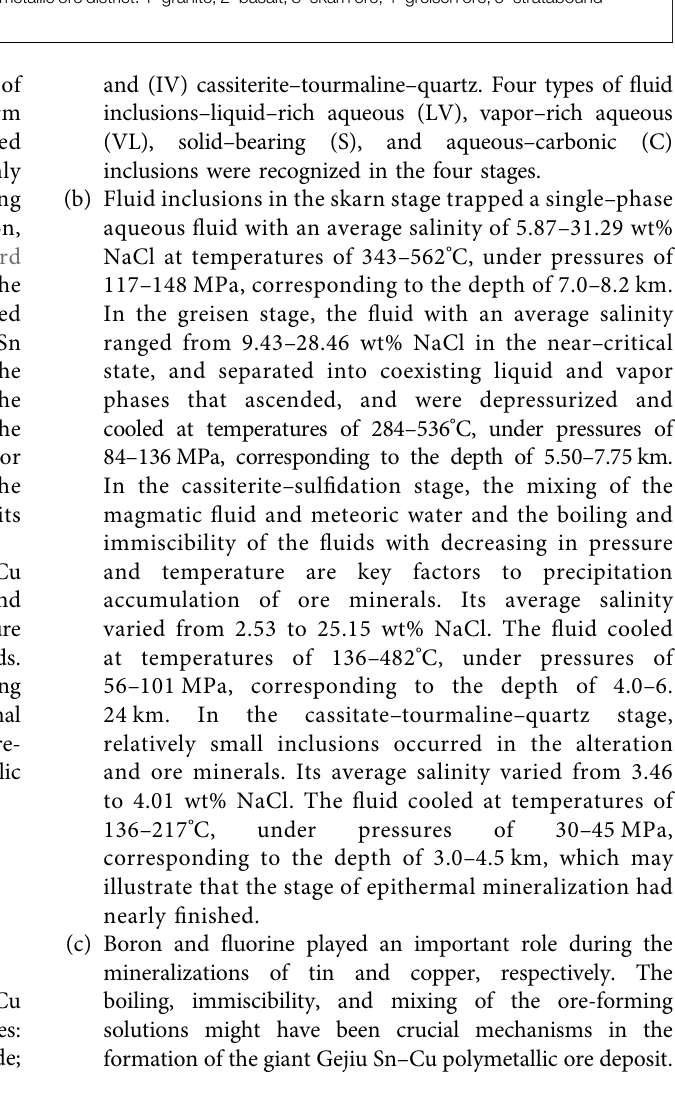
FIGURE10| Themodeloforeformationandpattern fortheGejiuSn – Cup polymetallicoredistrict.1 – granite;2 – basalt;3 – skarnore;4 – greisenore;5 – stratabound ore; 6 – stockwork